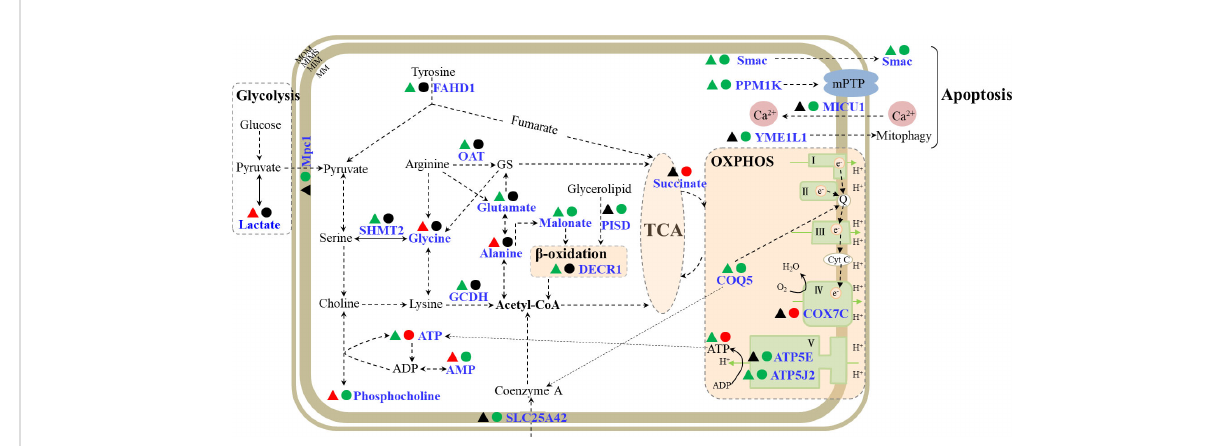
FIGURE 6 A schematic diagram of mitochondrial responses in fl ounder livers induced by Cd exposures. The metabolites and proteins involved in OXPHOS, TCA cycle and apoptosis were showed in the schematic. The responsive metabolites or proteins were marked in blue, and the down- and up- regulated proteins or metabolites in 5 m g/L ( ▴ ) and 50 m g/L ( ● ) Cd treatments were labeled in green and red. MIM, mitochondrial inner membrane; MOM, mitochondrial inner membrane; MIMS, mitochondrial intermembrane space; MS, mitochondrial matrix; OXPHOS, oxidative phosphorylation; TCA, tricarboxylic acid cycle; MPTP, mitochondrial permeability transition pore; GS, L-glutamate-5-semaldehyde; FAHD1, acylpyruvase; ATP5J2, ATP synthase subunit f; COQ5, 2-methoxy-6-polyprenyl-1,4-benzoquinol methylase; COX7C, cytochrome c oxidase subunit 7C; ATP5E, ATP synthase subunit epsilon; Mpc1, mitochondrial pyruvate carrier 1; SLC25A42, mitochondrial coenzyme A transporter; PISD, phosphatidylserine decarboxylase proenzyme; DECR1, 2,4-dienoyl-CoA reductase; GCDH, glutaryl-CoA dehydrogenase; OAT, ornithine aminotransferase; SHMT2, serine hydroxymethyltransferase; Smac, second mitochondria-derived activator of caspase homolog; PPM1K, protein phosphatase 1K; MICU1, calcium uptake protein 1; YME1L1, ATP-dependent zinc